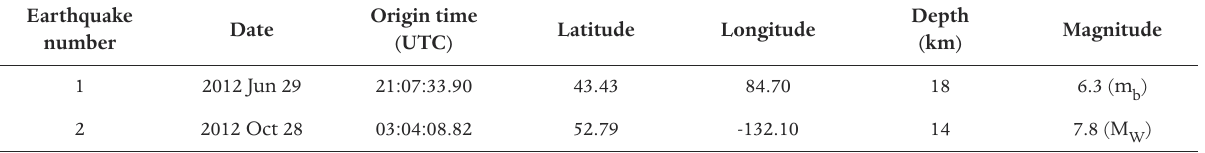
Table 2. The hypocentral parameters of the earthquakes used (from NEIC, USGS).